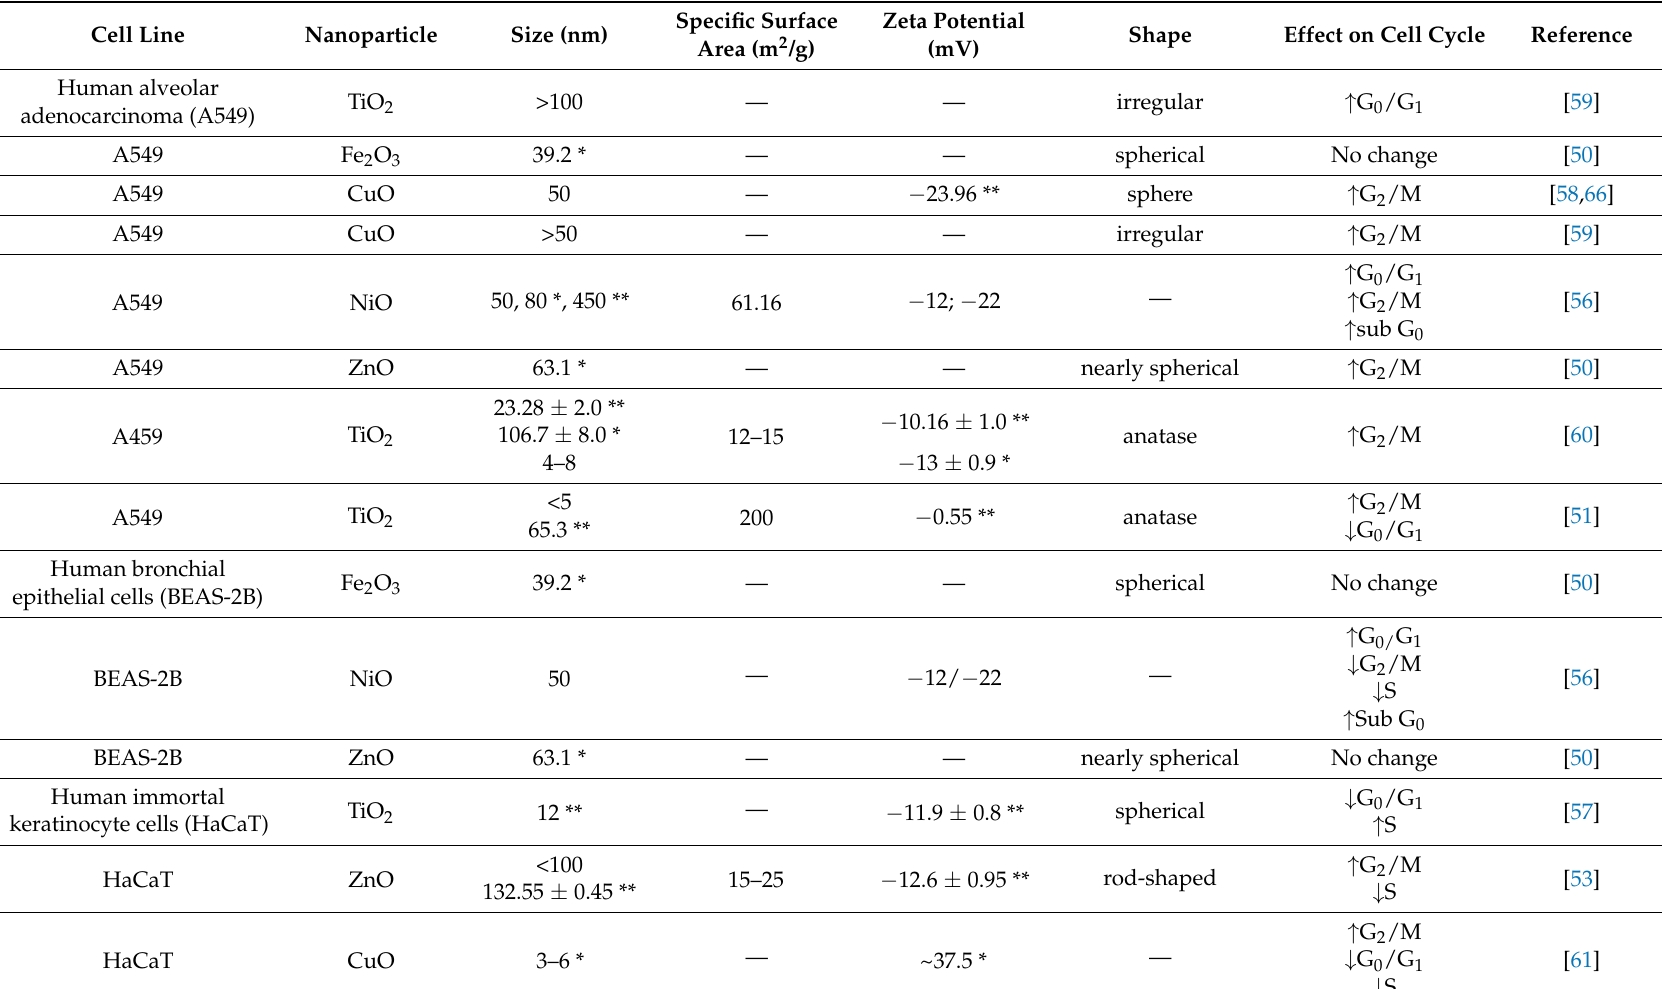
Table 2. Changes in cell cycle upon exposure to nanoparticles with a variety of characteristics in various cell lines. Cell